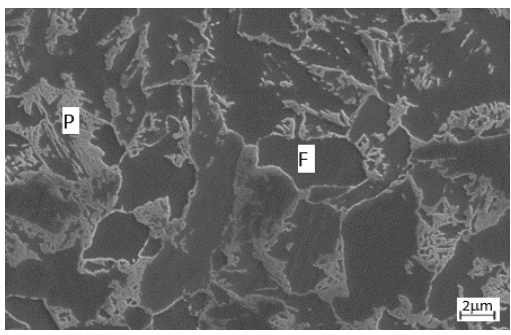
Figure 13. Heat treatment parameters: Soaking 850 °C/100 s, cooling rate 30 °C/s, bainitic hold 450 °C/600 s. Ferritic-bainitic microstructure with M-A constituent.